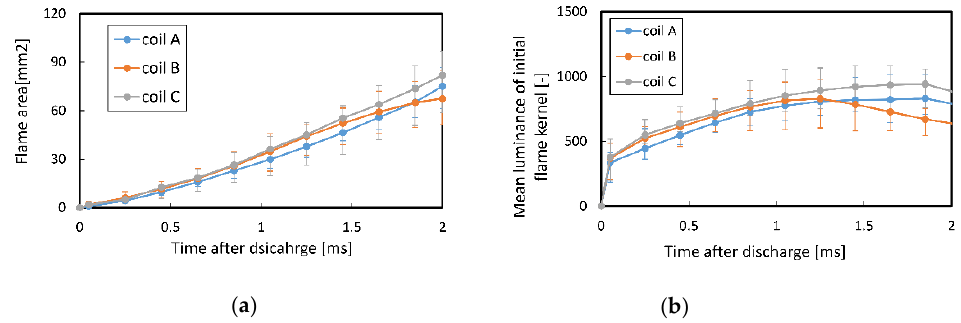
Figure 13. High diluted condition: ( a ) Initial flame area; ( b ) Initial flame luminance.